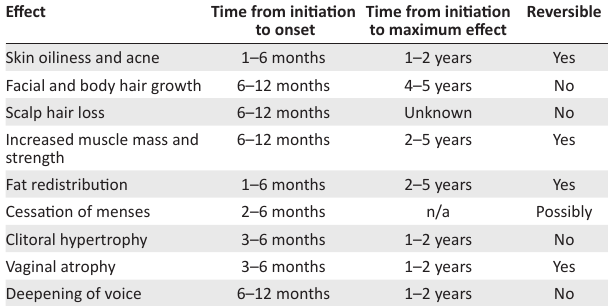
TABLE 8: Timeline and reversibility of masculinising hormone therapy.